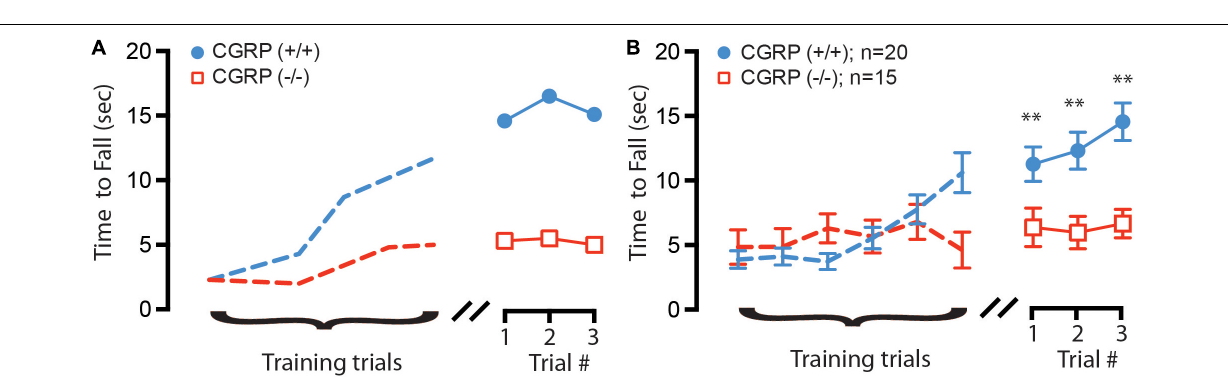
FIGURE 4 | (A) Example training (dashed lines) and testing trials for two 2 month (age-matched) female mice, with CGRP (–/–) null (red) and CGRP (+/+) control (blue) mice. (B) Composite training and testing trials for all mice, with CGRP (–/–) null (red, n = 20) mice fall off rotating rotarod on average 6.4 s sooner than CGRP (+/+) control (blue, n = 15) mice, ∗∗ p <